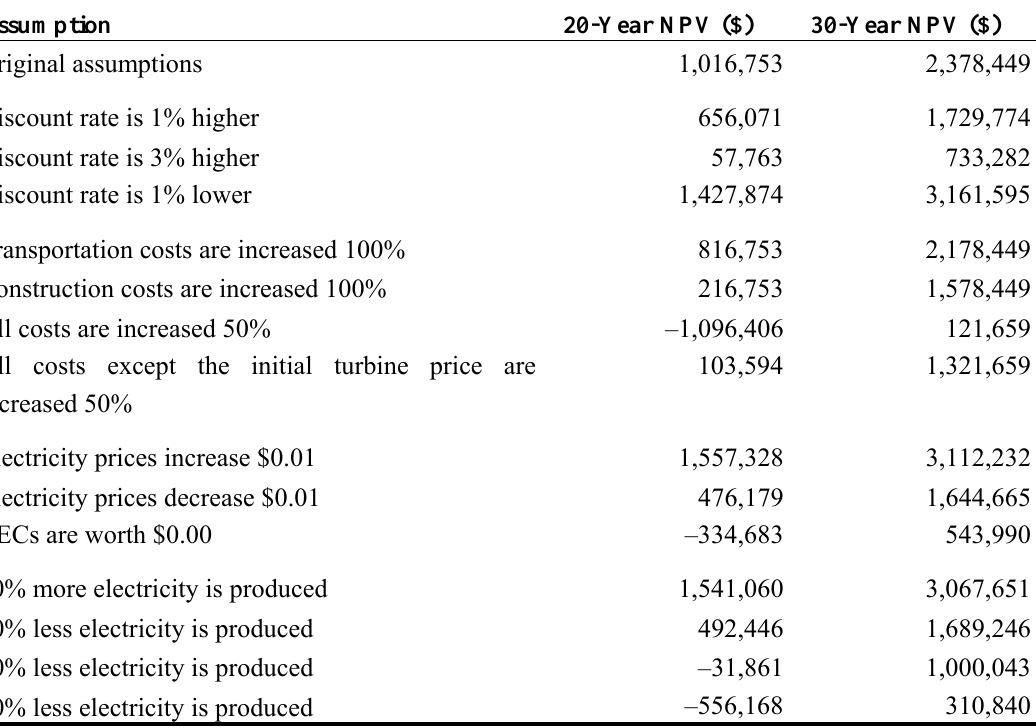
Table 5. The sensitivity